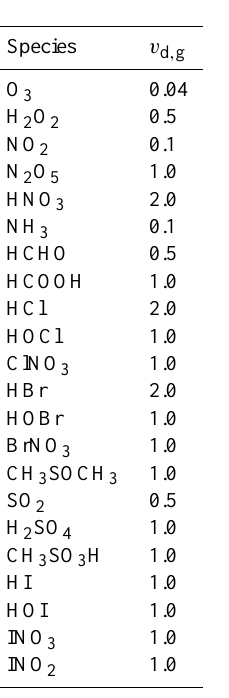
Fig. 2. Two I 2 emission scenarios used for the “low tide” model runs. The blue and red lines are for scenarios calculated using back trajectories from the Roscoff measurement site at 12:33 and 13:48, respectively, on 10 September 2006 (using an adapted version of the model of Leigh et al., 2010, see main text for